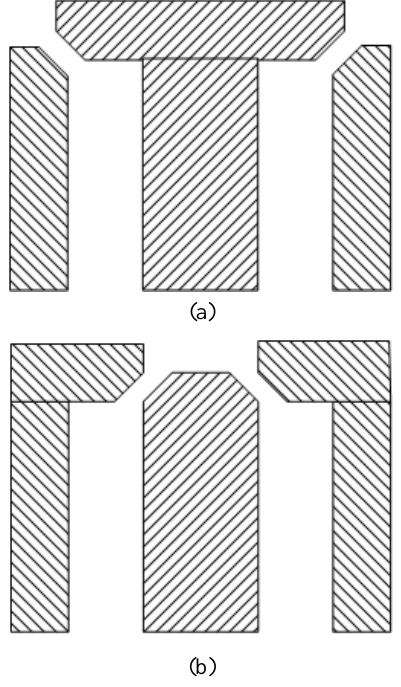
Fig. 12. Alternative designs of outlet nozzles with